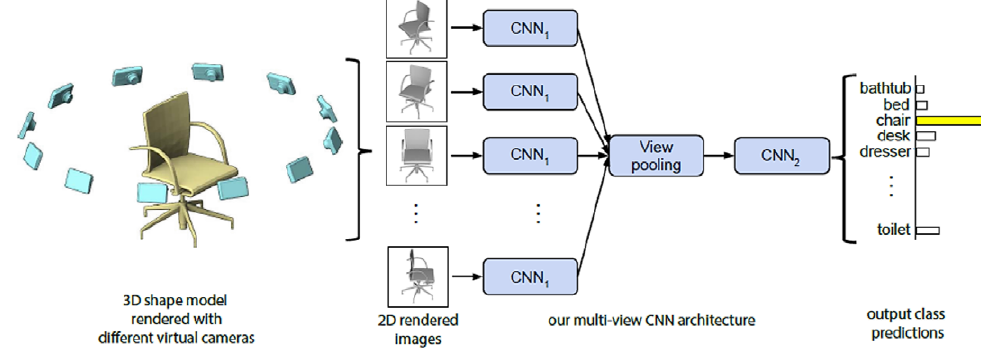
Figure 1. MVCNN architecture (Su et al., 2015)